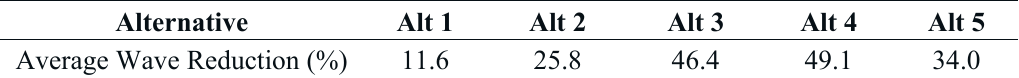
Table 6. Representative wave reduction ratings for Alts 1 to 5.